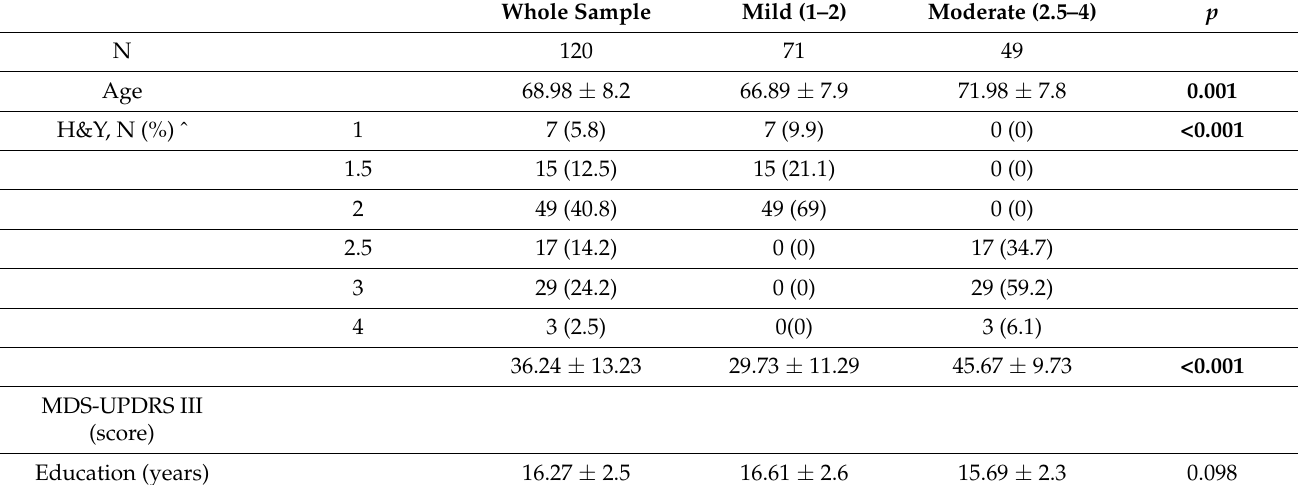
Table 1. Demographic characteristics of participants with mild vs. moderate stages of Parkinson’s